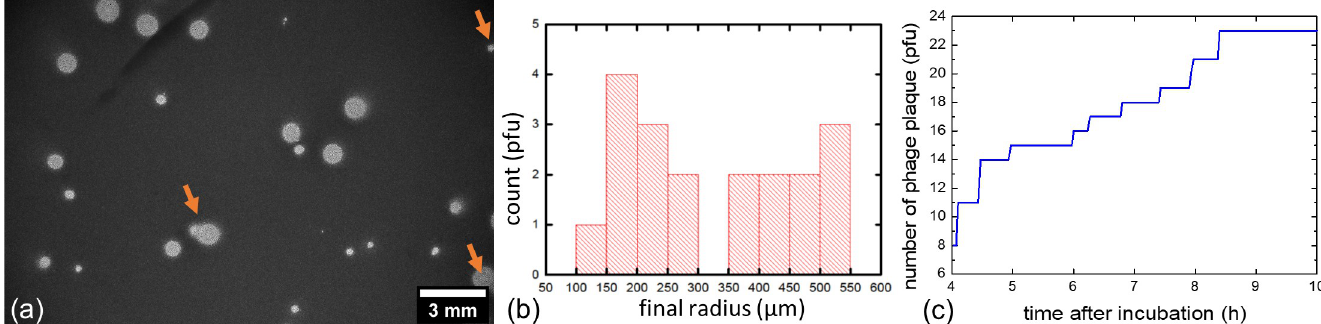
Fig 4. Acquisition of single-layer agar assay through lensless imaging. (a) Image of a single-layer soft agar assay after 21 hr 44 minutes of incubation at 37˚C, with the dark background corresponding to the area of bacterial growth and bright disks to lysis plaques. The orange arrows indicate plaques that were not excluded from the growth kinetics study. (b) Corresponding plaque radius histograms and (c) cumulative graph of plaques detected as a function of time.